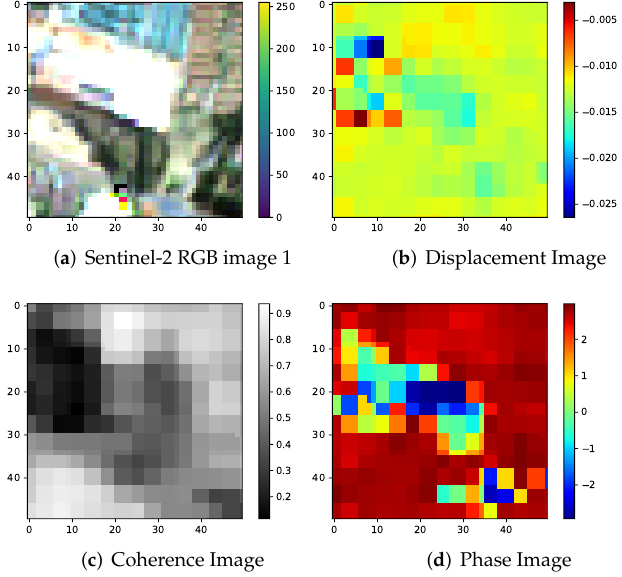
Figure 11. True-positive blob of a construction site in Thornhill